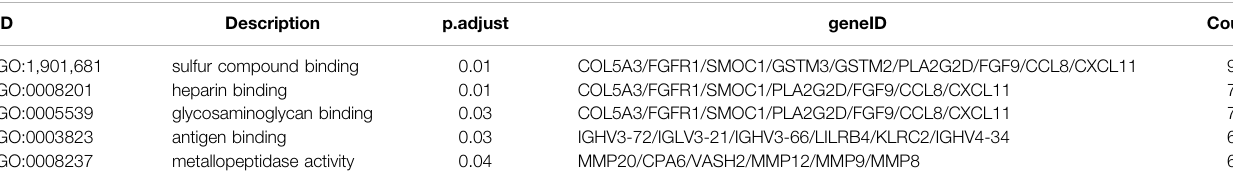
TABLE 3 | Results of GO enrichment analysis of differential genes.